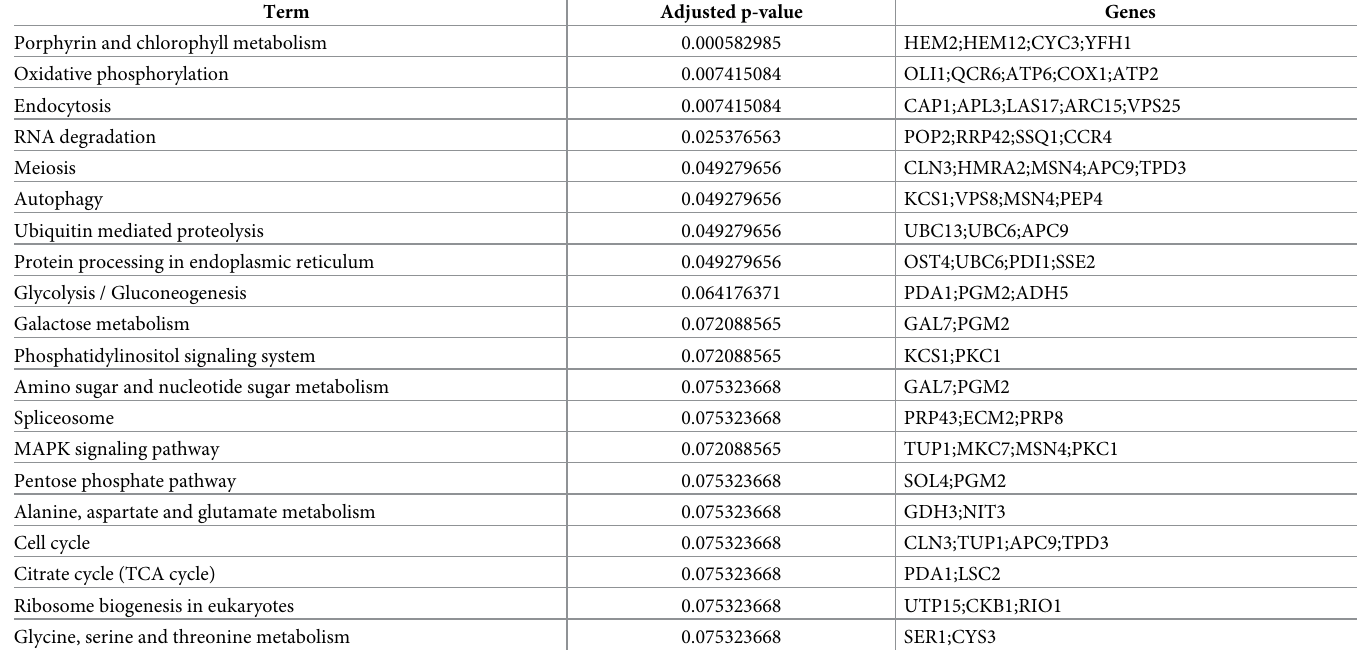
Table 3. KEGG enrichment analysis of 171 probe sets. The significant pathways with adjusted p-value < 0.1 are